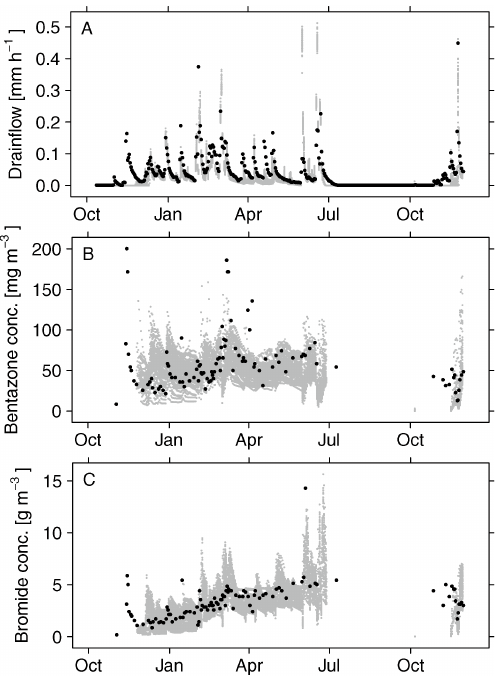
Fig. 2. Comparison between measurements (black) and the simula- tion results of all 56 acceptable parameter sets (grey) for (A) drain flow, (B) bentazone and (C) bromide concentrations in the drain